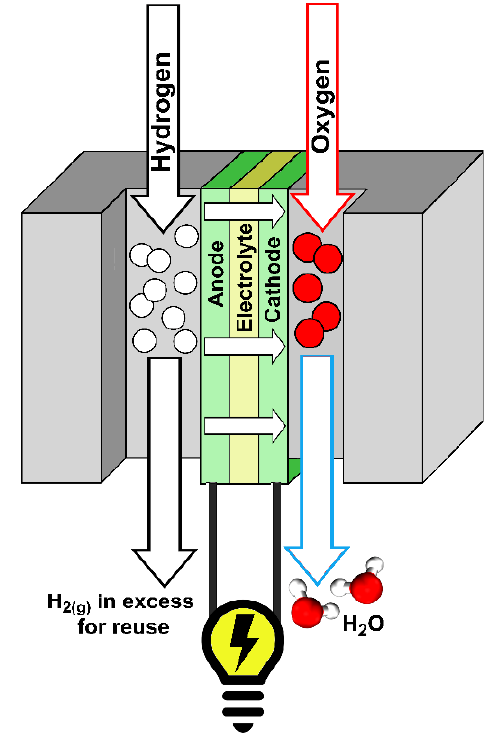
Figure 17. Simple scheme of the electrolytic cell used in fuel cells.